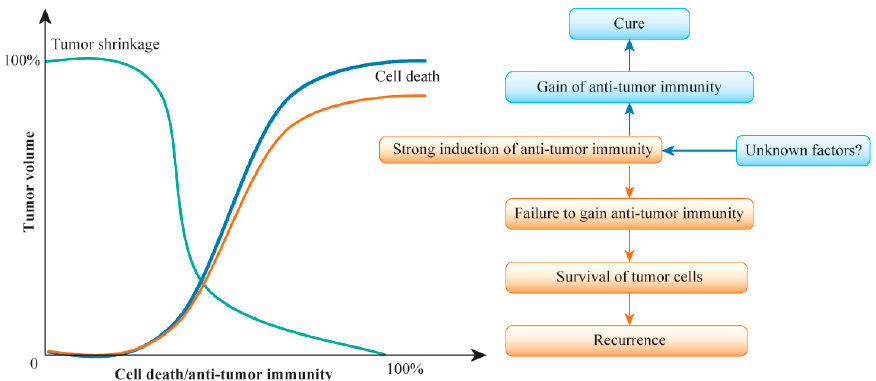
Figure 3. Hypothesized relationships of tumor volume to cell death and antitumor immunity after (neo)adjuvant chemotherapy for primary breast cancer. Decreased tumor volume is hypothesized to be related synergistically to increased cell death and the induction of antitumor immunity. The degree of increased cell death is almost parallel to the degree of